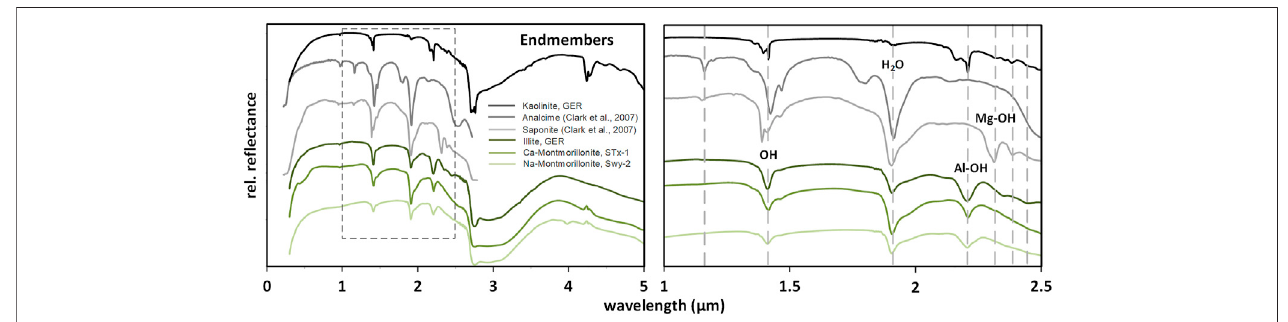
FIGURE 4 | Left – Relative re fl ectance spectra between 0.25 and 5 μ m of possible mineral endmembers for comparison to CHB. Right — Detailed view of the spectral range between 1 and 2.5 μ m with marking of characteristic absorption bands: 1.16 μ m — analcime, 1.4 μ m — OH, 1.9 μ m — H 2 O, 2.2 μ m — Al –